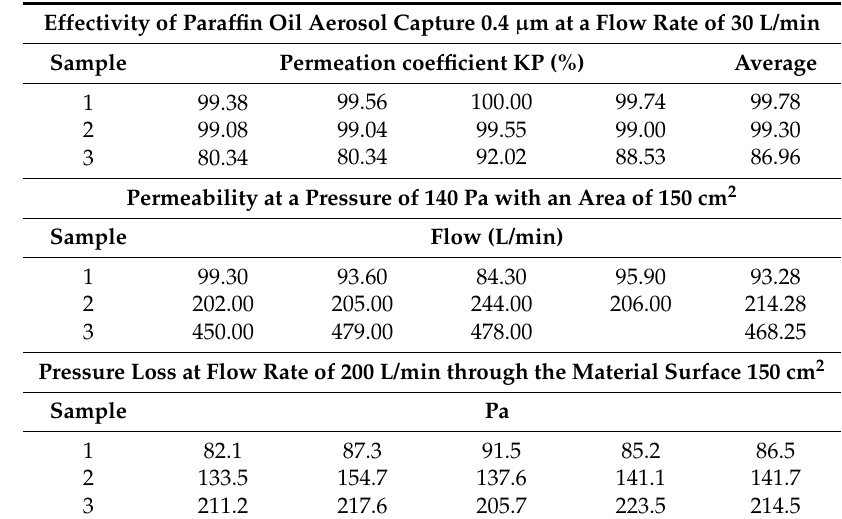
Table 3. Evaluation results of the filtration membrane from PA-6 nanofibers coated on both sides with NT BICO Fibertex nonwoven, weighing 150 g/m 2 after calibration to a thickness of 2